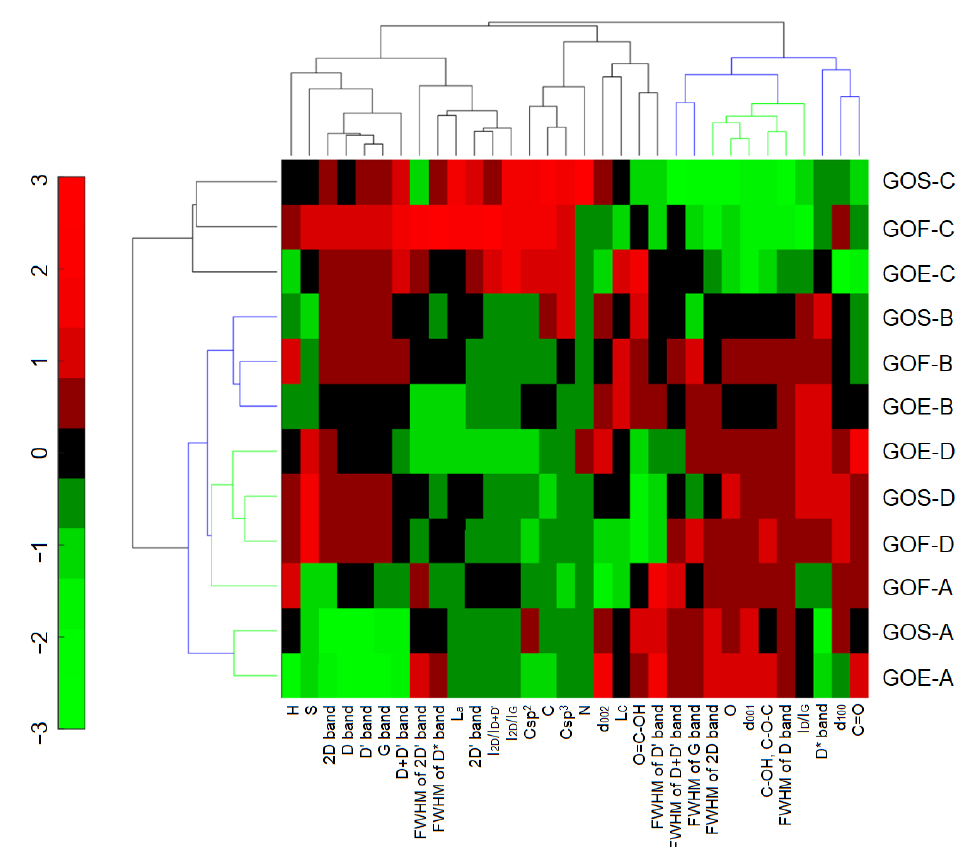
Figure 1. The clustered heat map for the studied GO samples and their properties.